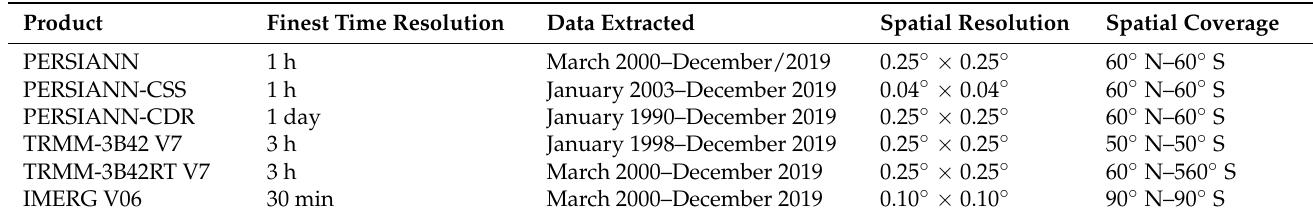
Table 2. Details of